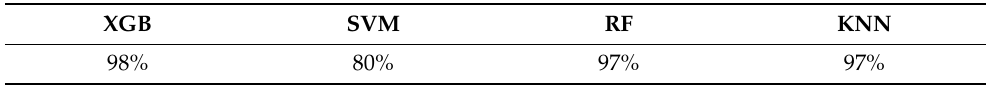
Figure 13. Prediction results from training in different ground truth locations (ROIs) using different machine learning models. Table 12. Overall validation accuracy of different machine learning models for detection of mouse ear hawkweed foliage at 0.65 cm/pixel at the study site.